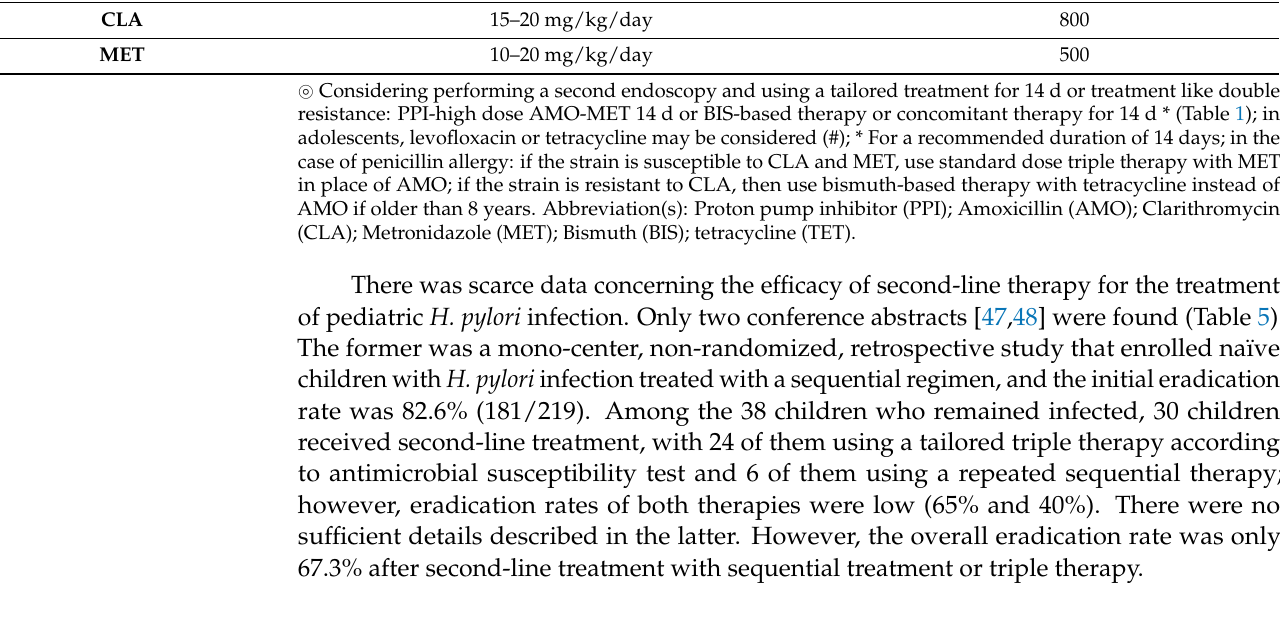
Table 5. Eradication rates of second-line treatment for pediatric H. pylori